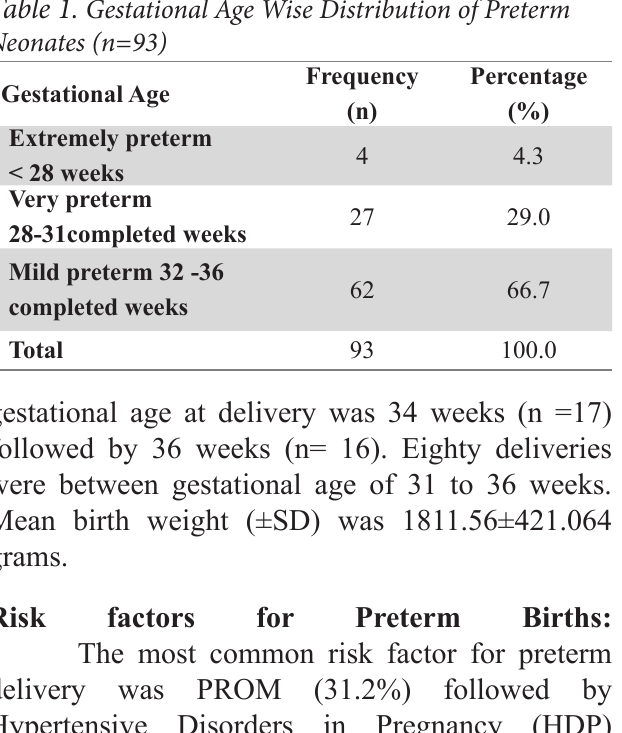
Table 1. Gestational Age Wise Distribution of